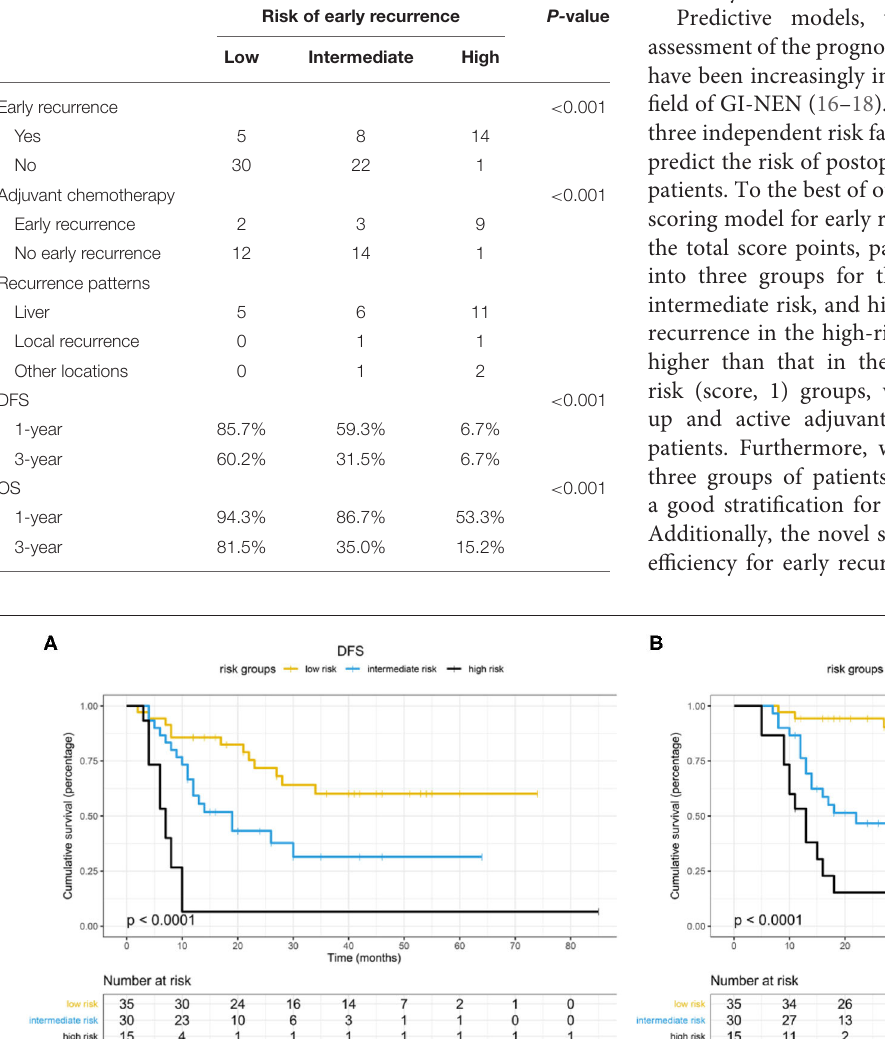
Frontiers in Surgery |